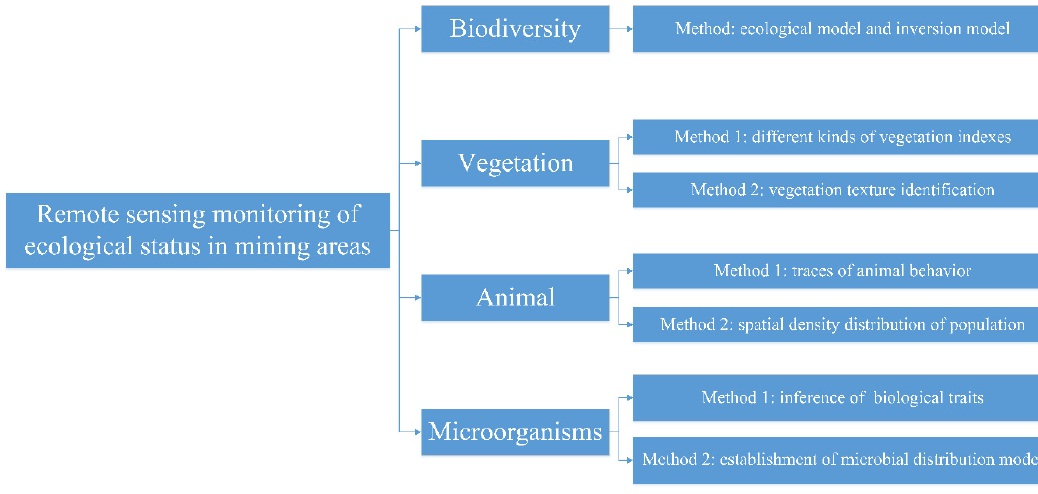
Figure 1. Biodiversity monitoring